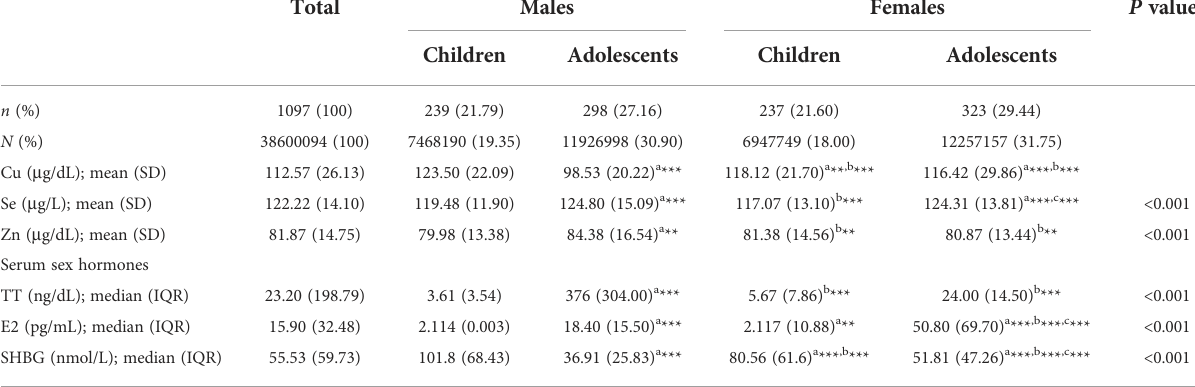
TABLE 2 Descriptive statistics for trace elements and sex steroid hormones in different subgroups.